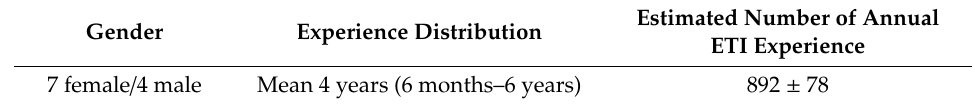
Table 1. Demographic data of participants. ETI—endotracheal